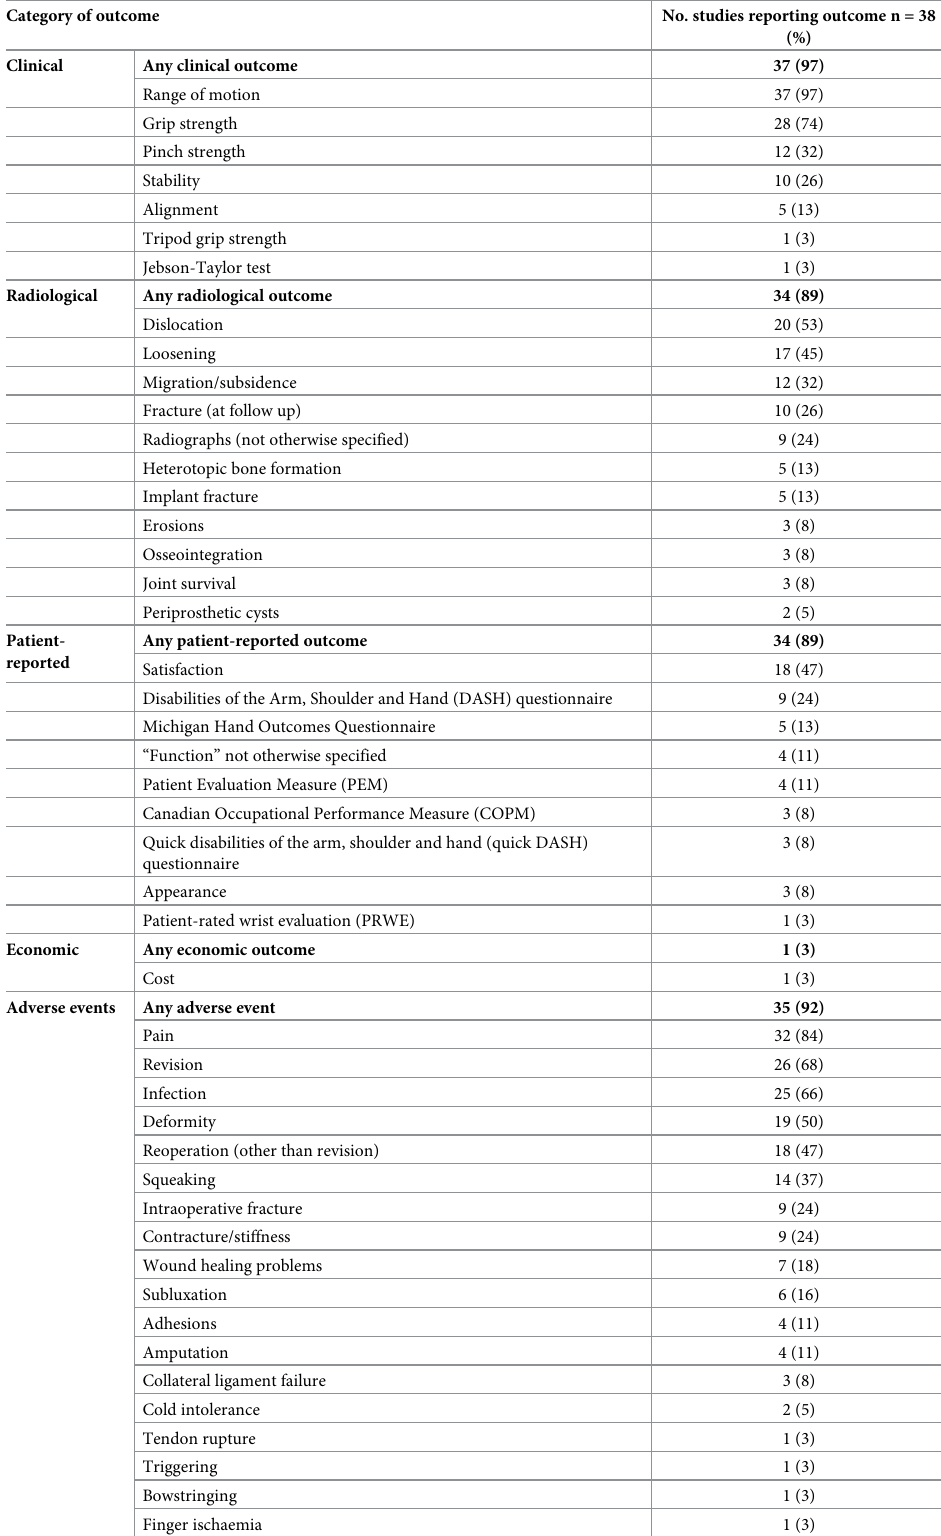
Table 5. Outcome reporting in included